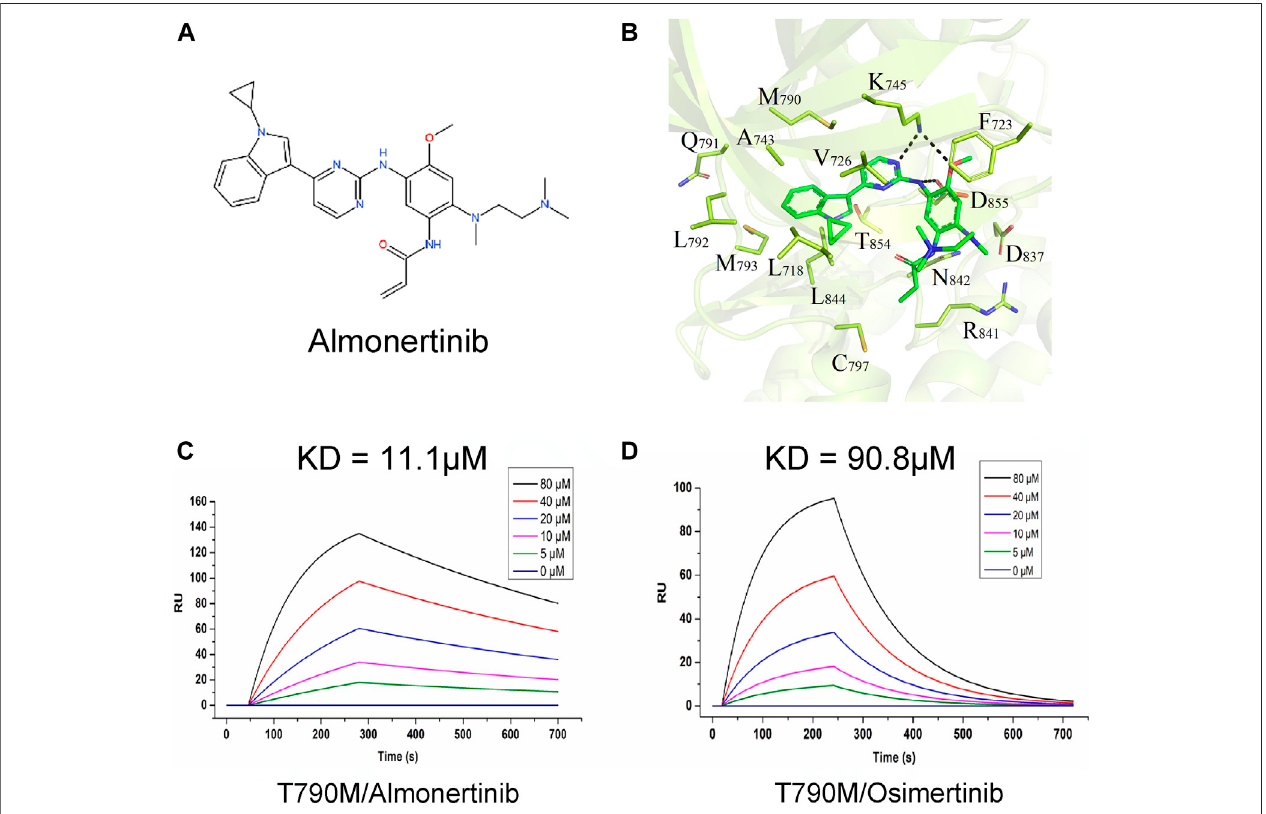
FIGURE 1 | Interaction between almonertinib and EGFR-T790 mutant protein. (A) Chemical structure of almonertinib; (B) molecular model diagram of interaction between almonertinib and EGFR T790M mutation; (C) determination of the af fi nity of EGFR T790M and almonertinib using the SPR method, the af fi nity constant was 11.1 μ M; (D) the af fi nity of EGFR T790M and osimertinib was 90.8 μ